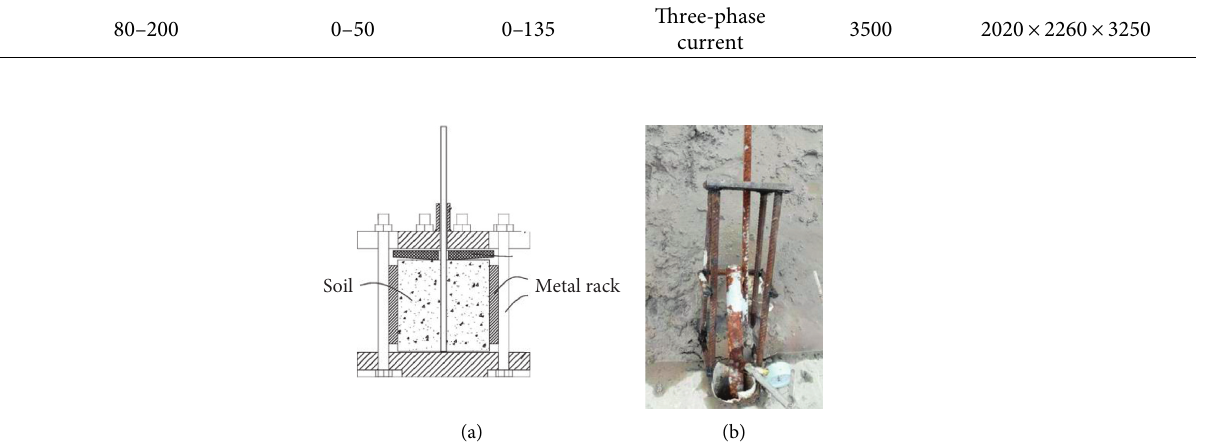
Figure 3: The auxiliary device of the field pullout experiment. (a) The schematic diagram of the auxiliary device in the field pullout experiment. (b) Field installation of the auxiliary device in the field pullout experiment.